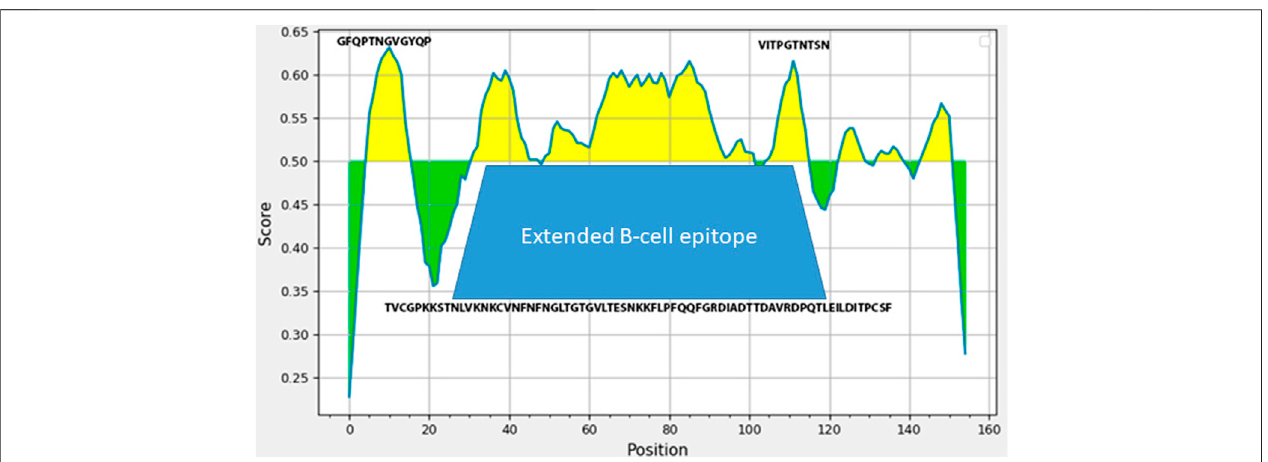
FIGURE 1 | Analysis of SARS-Cov-2 S-protein fragment (amino acids 496-646 in SARS-Cov-2 S protein sequence) employing IDEB (Immune Epitope Database). The amino-acids sequence underneath the trapezoid fi gure represents large 53 AA immunogenic domain of